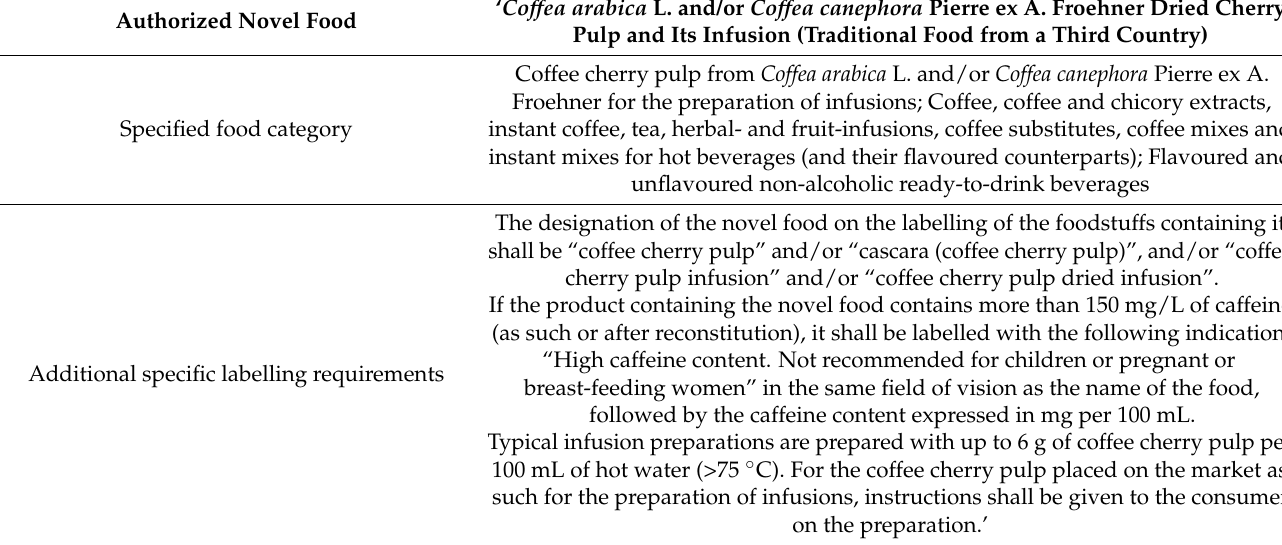
Table 3. Specifications of Commission Implementing Regulation (EU) 2022/47 of 13 January 2022 authorising the placing on the market of Coffea arabica L. and/or Coffea canephora Pierre ex A. Froehner dried cherry pulp and its infusion as a traditional food from a third country